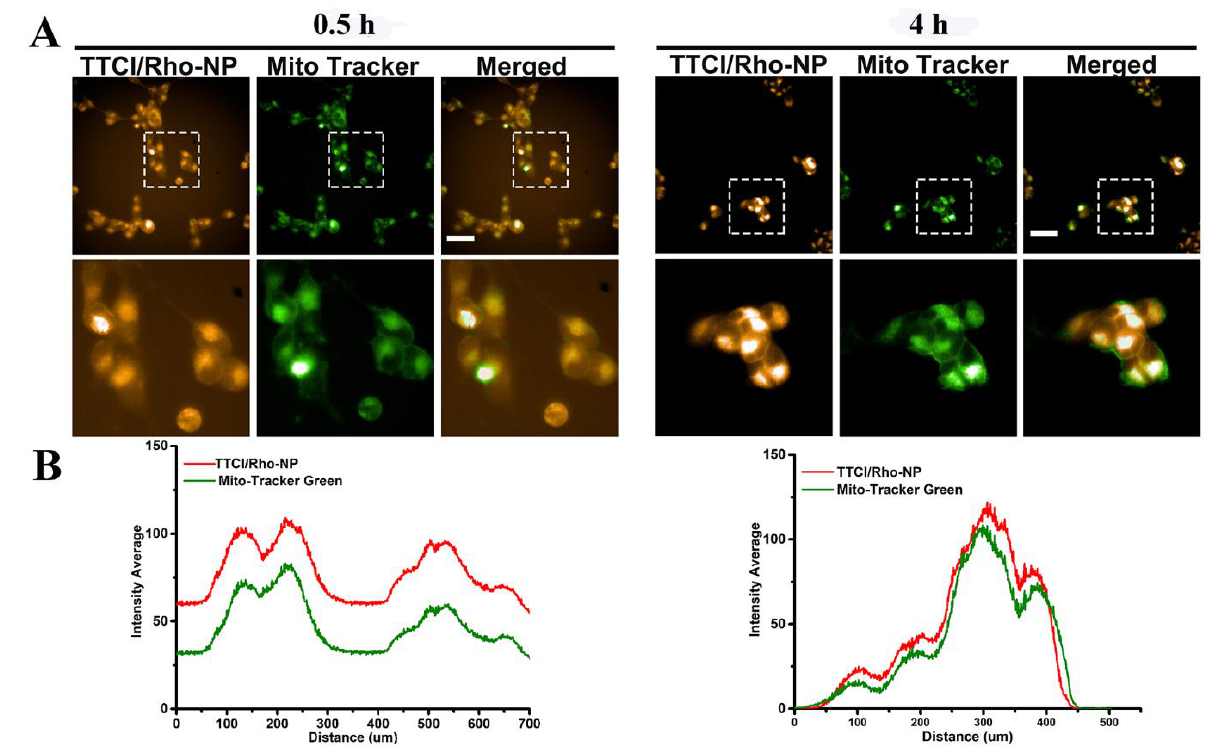
Figure 3. Mitochondria-targeting ability of TTCI / Rho NPs in vitro: Images of the BxPC3 cells treated with TTCI/Rho NPs at a concentration of 20 µ M for 0.5 and 4 h, captured by high content analysis system-operetta CLS TM . For each row, from left to right: TTCI/Rho NPs (546 nm excitations); mitochondria stained by MitoTracker Green (488 nm excitation); merged image ( A ). Scale bars: 50 µ m. The cross-section fluorescence intensity of Rhodamine B and MitoTracker Green in the enlarged regions analyzed using imageJ software ( B ).